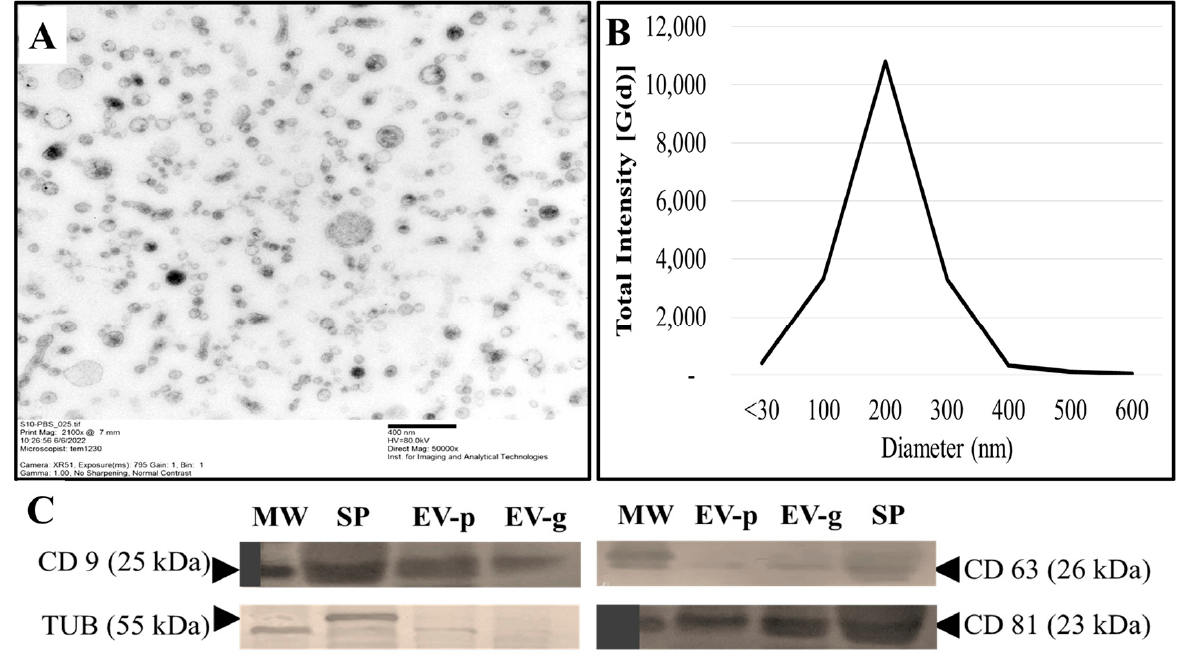
Figure 1. Characterization of extracellular vesicles isolated from boar seminal plasma (SP-EVs). The micrograph is a representative high-resolution transmission electron microscopy (HR-TEM) image of SP-EVs. Scale bar represents 400nm ( A ). Dynamic light scattering (DLS) size measurement and distribution of SP-EVs particles ( B ). Representative immunoblotting of SP-EV samples with exosome (CD63 and CD81) and microsomes (CD63 and CD9) markers ( C ).